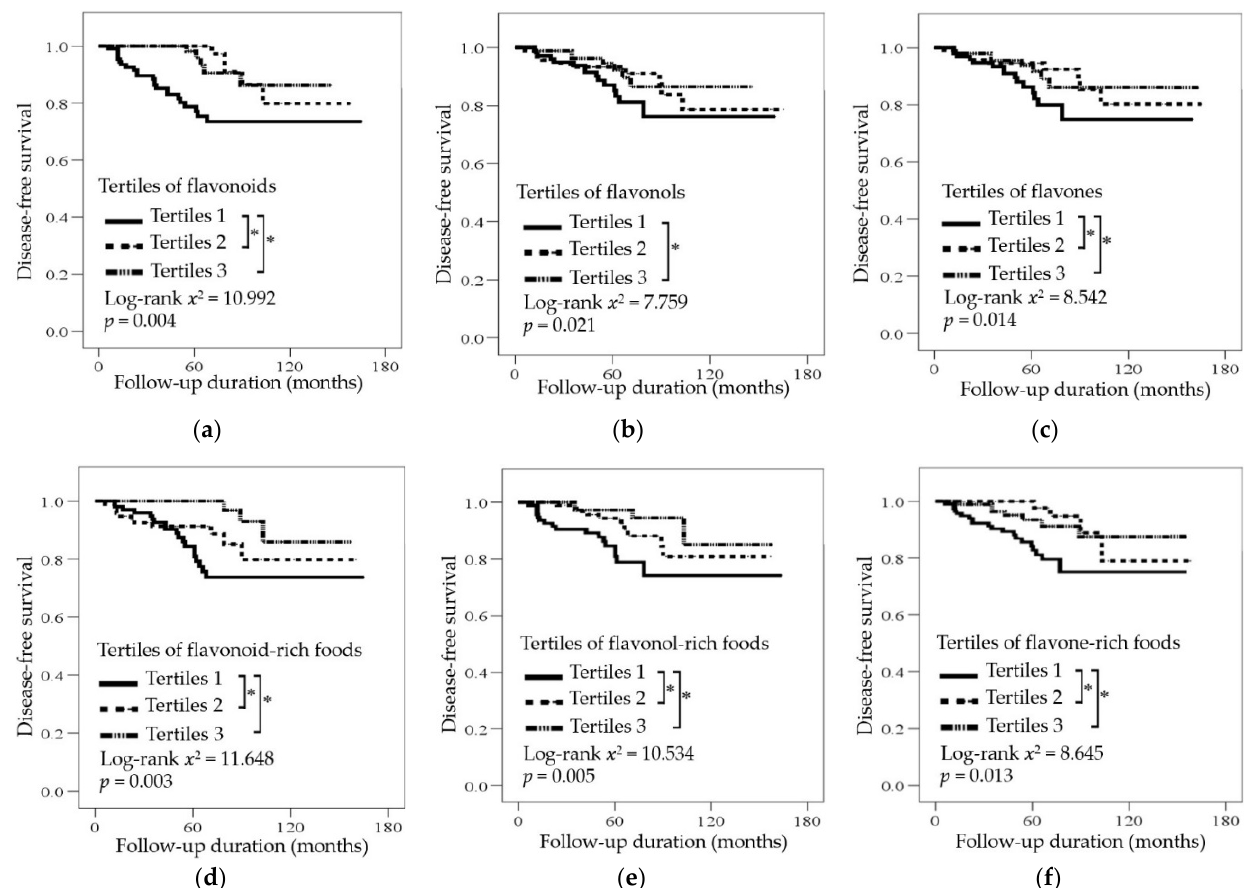
Figure 2. Cumulative disease-free survival according to the tertiles of flavonoid ( a – c ) or flavonoid-rich food intake ( d – f ) in overweight and obese patients with breast cancer. Statistical significance was determined using the log-rank test and the Kaplan–Meier method; * p < 0.05. Table 4. Association between dietary intake of flavonoid-rich foods and cancer recurrence in overweight and obese patients. Tertiles of Flavonoid-Rich Food Intake p for Continuous Trend 1 T1 T2 T3